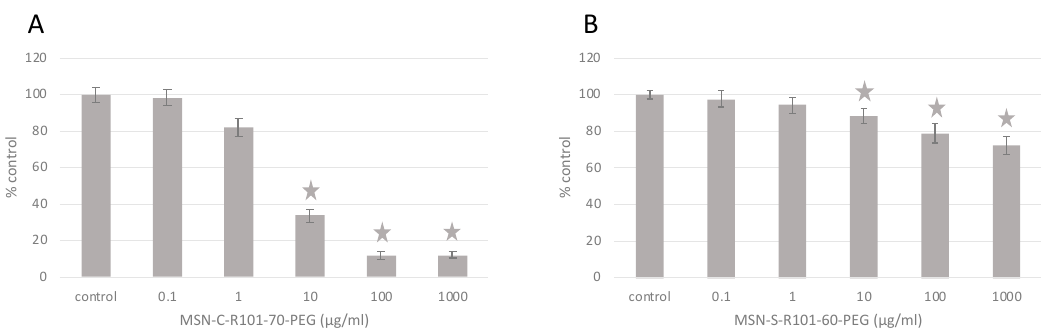
Figure 5. Results of MTT assay for MSN-C-R101-70-PEG ( A ) and MSN-S-R101-60-PEG ( B ). Stars indicate significant differences with respect to controls according to the Kruskal – Wallis test followed by the Dunn´s test ( p < 0.05).